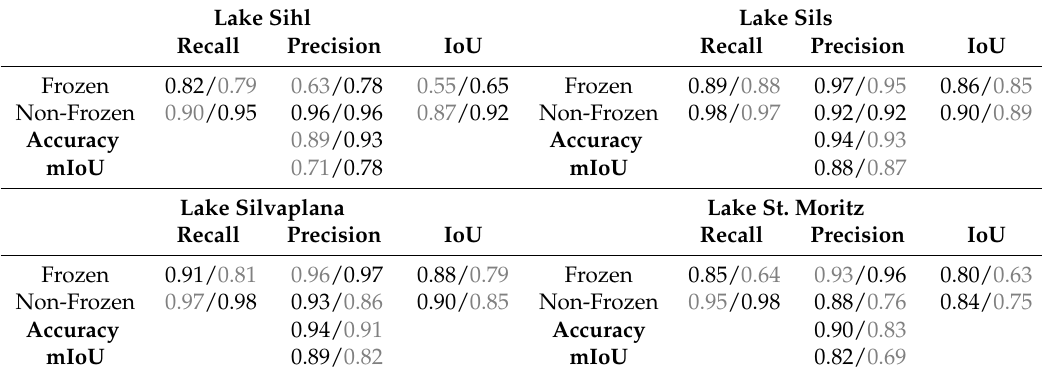
Table 9. MODIS leave one lake out results. Numbers are in A/B format where A and B represent the results using Radial Basis Function (RBF) and linear kernels, respectively. The better kernel for a given experiment is shown in black, worse kernel in grey.